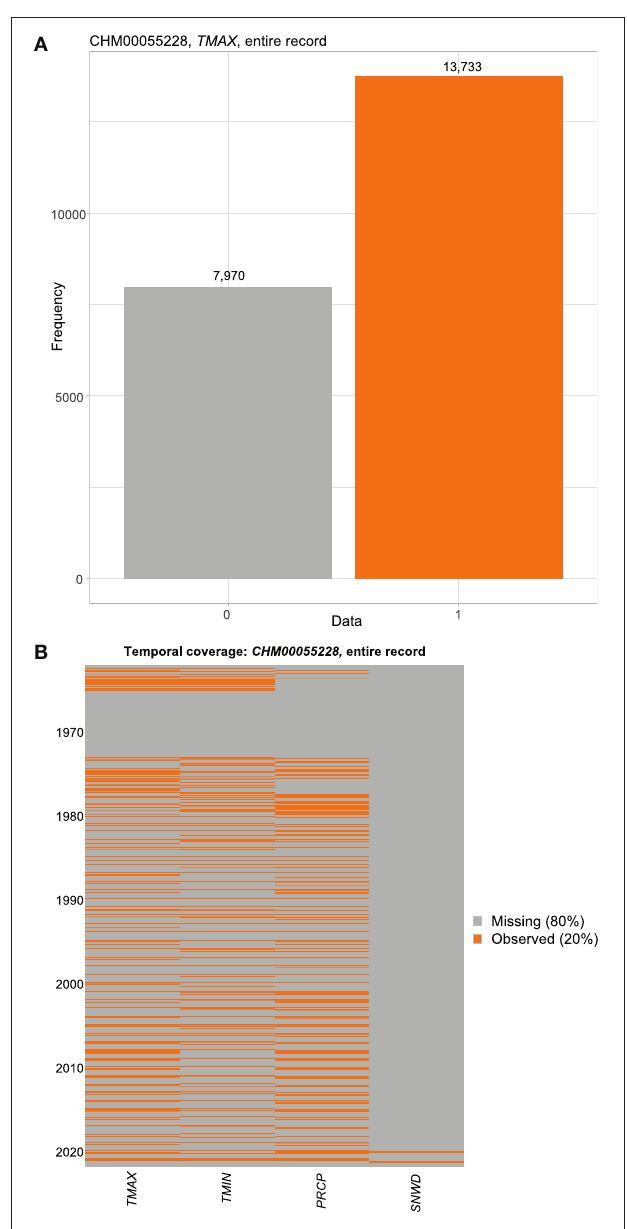
FIGURE 7 | Examples of temporal coverage plots generated using the script developed. Frequency of observations vs. missing data for a particular variable TMAX at a given station (CHM00055228) (A) , and an illustration of observations vs. missing data on a daily basis at the same station for all core variables (B) . The percentages correspond to the integrated proportion of observed to missing data across the four variables for their combined maximum record length. The script also enables users to make arbitrary temporal subsets of any data